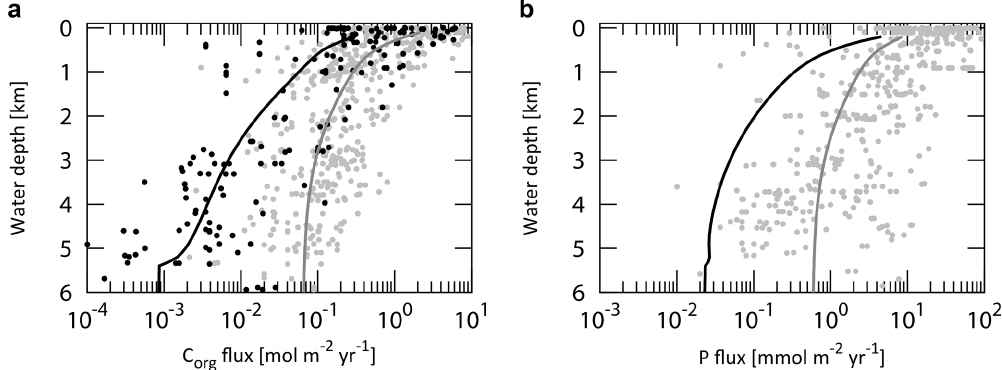
Figure 13. Simulated steady-state depth profiles of organic C and reactive P flux density for the LD region. In (a) , gray dots denote obser- vations of depositional/settling flux density, whereas black dots represent observations of burial flux density compiled from literature survey (Baturin, 2007; Betts and Holland, 1991; Colman and Holland, 2000; Lutz et al., 2002). Solid gray and black lines denote the simulated POC depositional and burial flux densities obtained from the reference run. (b) Gray dots denote the benthic P efflux density obtained from literature survey (Hartnett and Devol, 2003; Hensen et al., 1998; Ingall and Jahnke, 1994, 1997; McManus et al., 1997; Colman and Holland, 2000; Schenau and De Lange, 2001; Zabel et al., 1998), whereas solid gray and black lines represent the simulated benthic P efflux density and burial flux density of reactive P obtained from the reference run. The burial flux density of reactive P is not shown due to the sparseness of such observations.